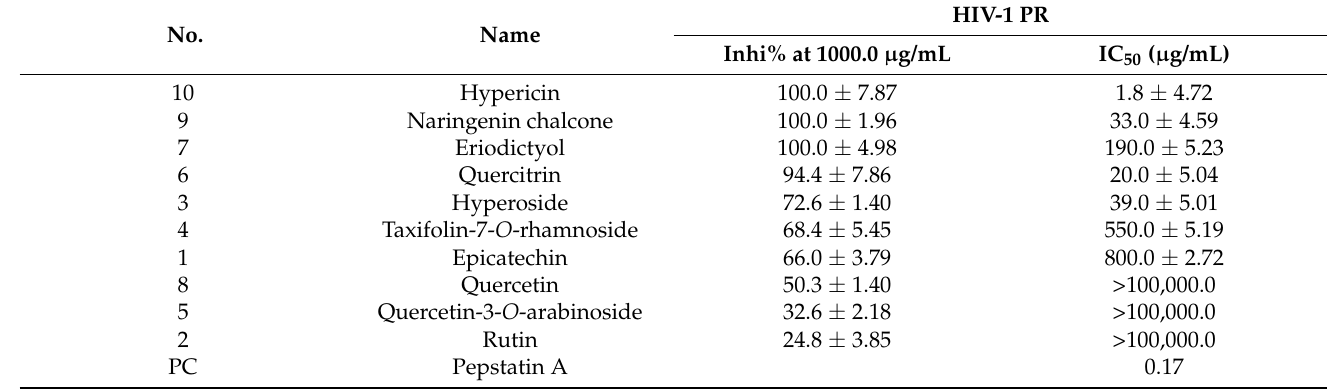
Table 5. Inhibition of HIV-1 PR by the 10 active compounds in H. kouytchense insect gall extracts ( n = 3). No.